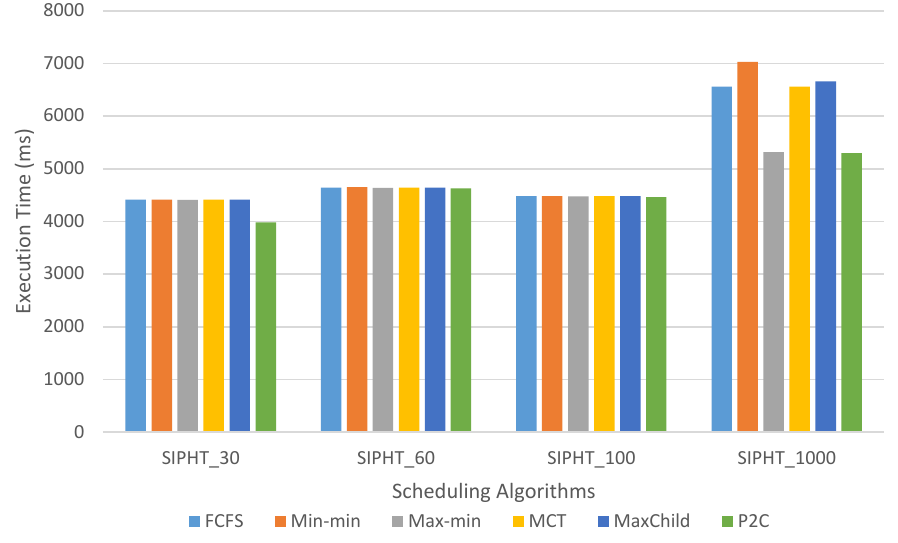
Figure 16. Comparison of execution time for SIPHT